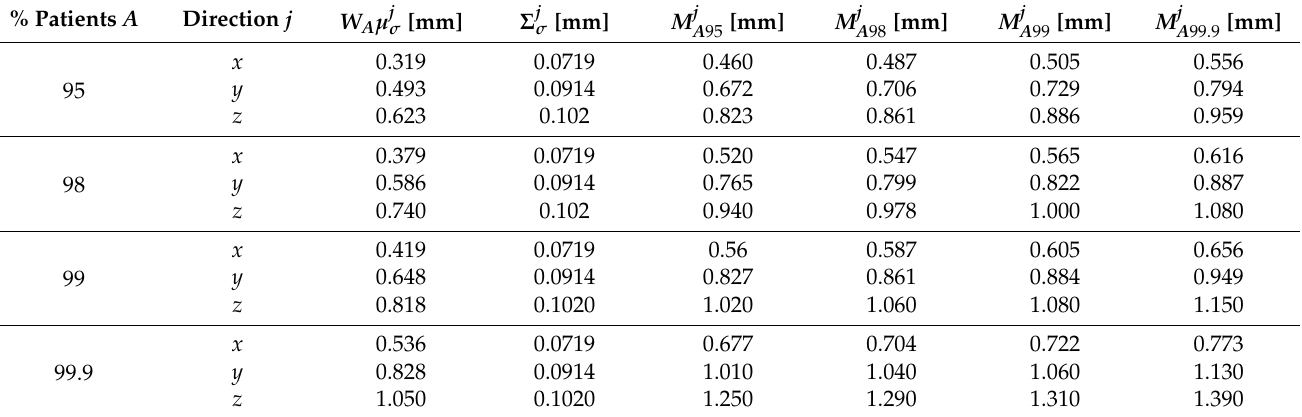
Table 2. Safety margins using the time length intervals I = 0 s.